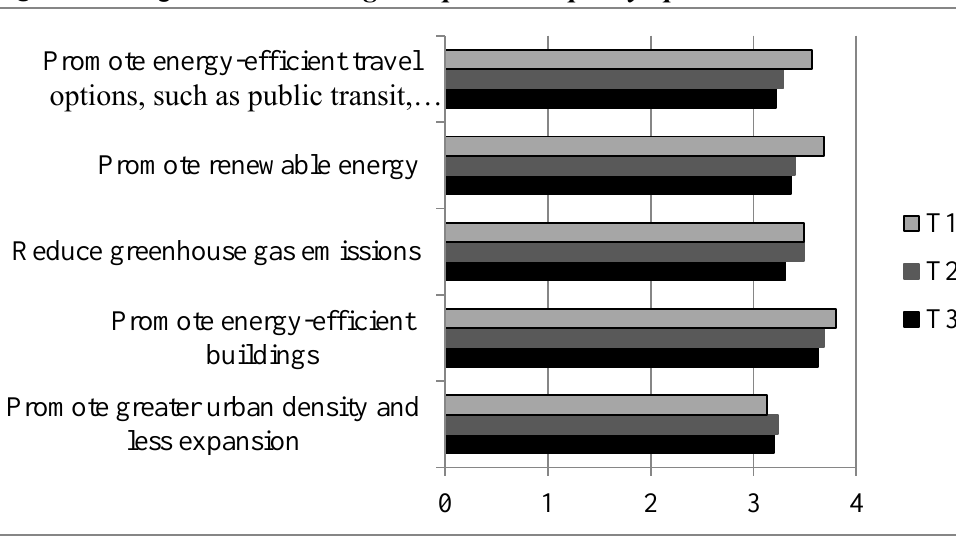
Figure 1: Trajectories of changes in panelists’ policy